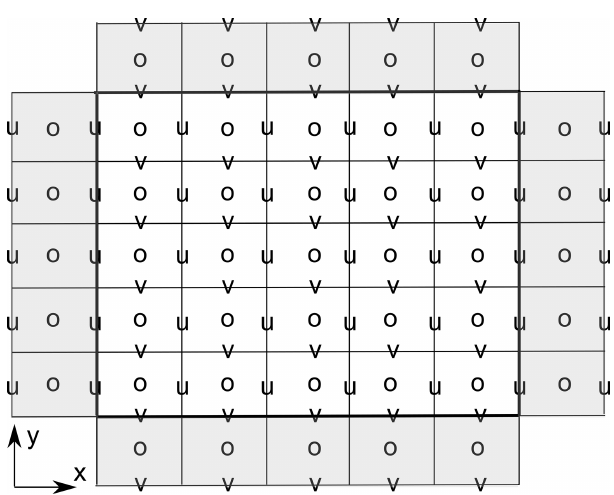
Figure 2. Arakawa D grid on a 2-D computational domain limited by the bold line. Scalar quantities are stored/computed at the cen- tre of the cells (empty circles), whereas the u and v velocity com- ponents are staggered at its respective cell faces. One row of ghost cells is shown in grey for reference; the actual number of ghost cells needed depends on the numerical stencil (order of the solving algo- rithm). The 3-D grid is formed as a succession of 2-D layers, with the w velocity components at the bottom/top faces of the